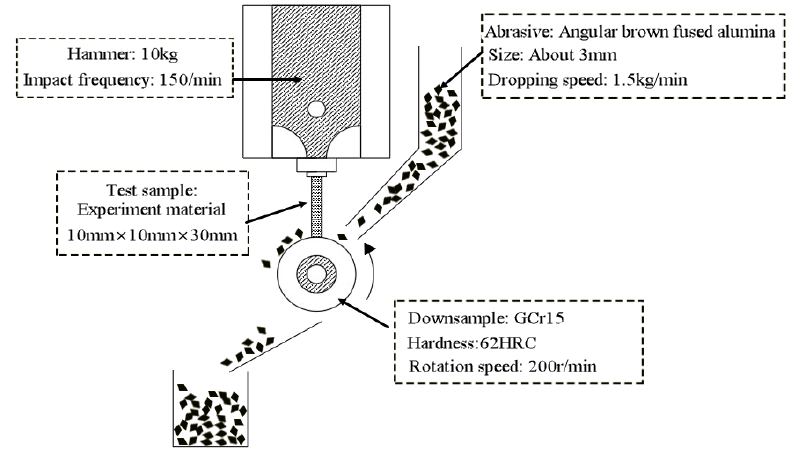
Figure 3. Schematic diagram of the impact-abrasive wear machine.